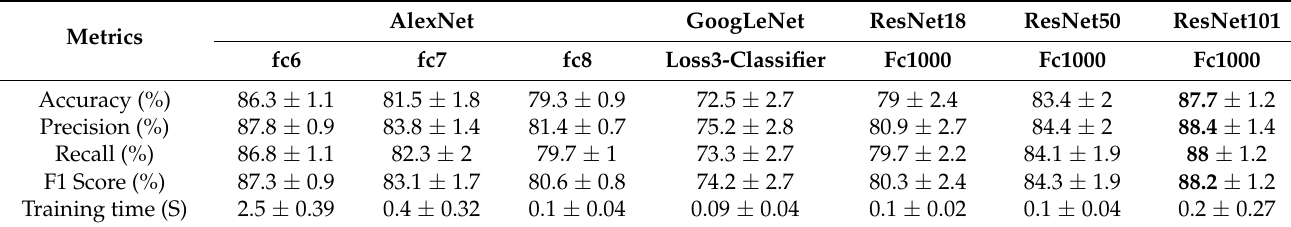
Table 2. Performance metrics and training time of SVM classifier with a single deep feature (bold font shows the best